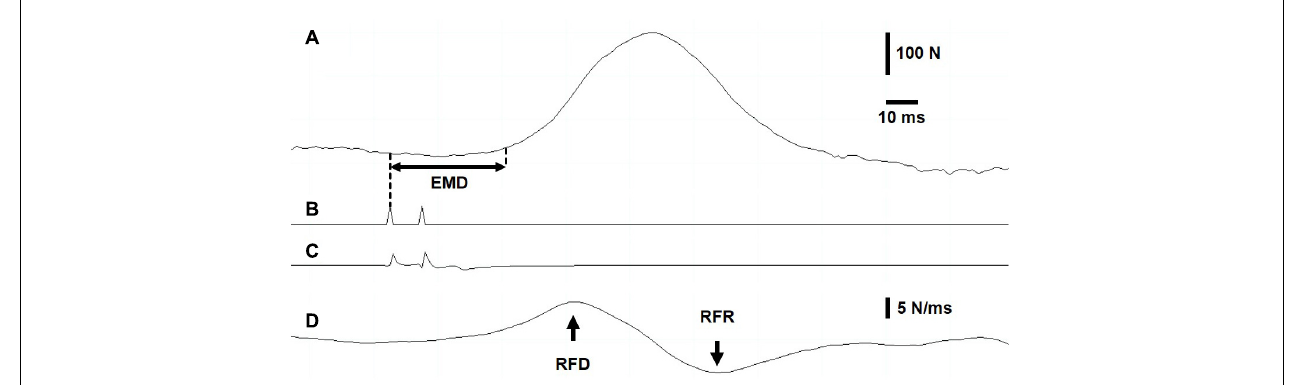
FIGURE 2 | Intratwitch indices measurement during dynamic exercise. Screenshot recording. (A) Force recording. The electromechanical delay was measured as the interval between the first electrical stimulation (B) of the doublet and the onset of force production, defined as 5% of evoked peak force. (C) Stimulation artifact on vastus lateralis electromyogram. (D) The maximal rates of force development and relaxation were determined as the highest value and the lowest value, respectively, of the first derivative of the force signal.